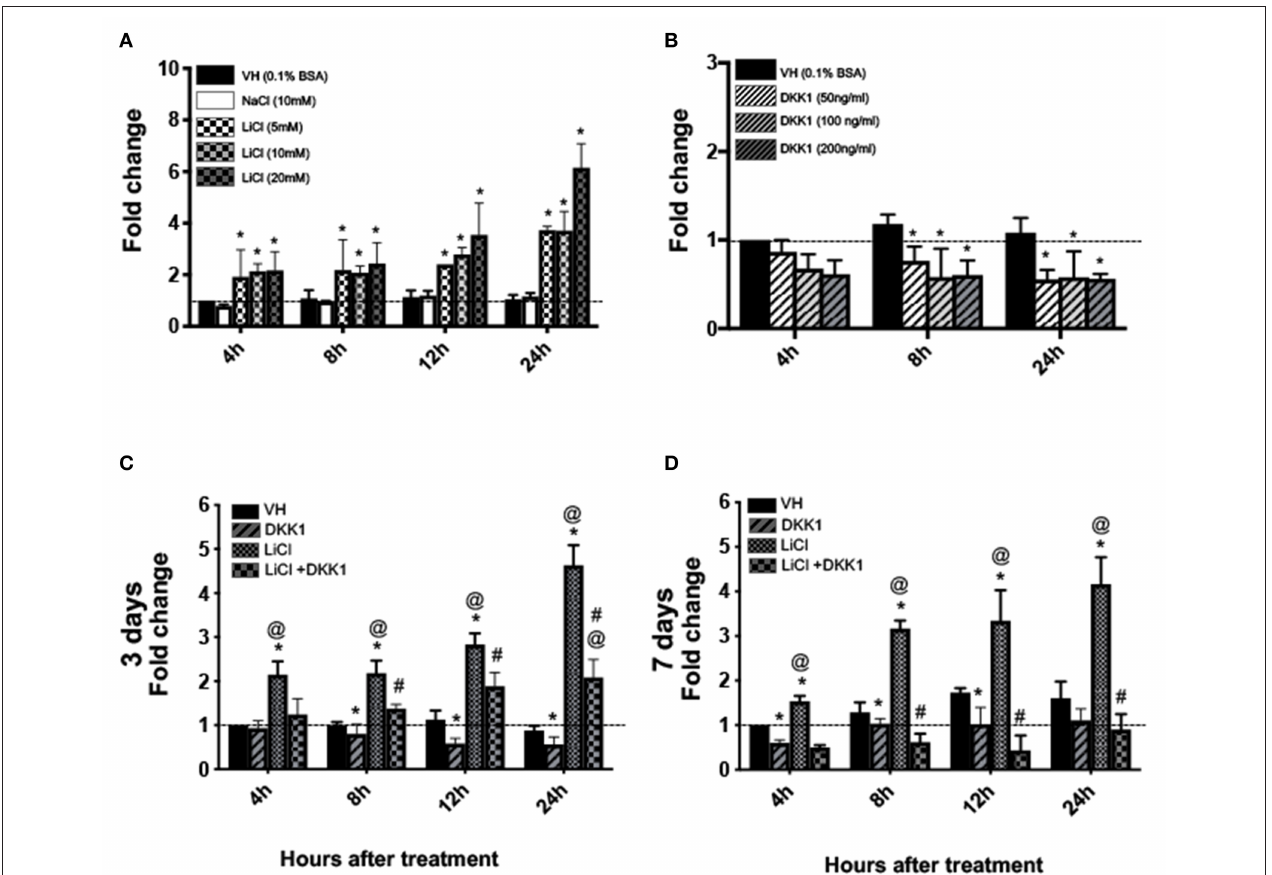
FIGURE 1 | Effects of LiCl on Axin2-expression in primary pulp cultures cultures. (A,B) Graphs showing the dose-dependent changes in the expression of Axin2 in cultures treated with Vehicle (VH, 0.1% BSA), (A) NaCl (10mM), LiCl (5, 10, and 20mM), and (B) DKK1 (50, 100, and 200ng/ml) between 4 and 24h after treatment at various times at day 3. (C,D) Graphs showing changes in the expression of Axin2 between 4 and 24h in cultures with various treatments at day 3 (C) and day 7 (D) . Expression of Axin2 was normalized to 4h of the VH-treated cultures, which is arbitrarily set to 1 and is indicated by the dashed line. Results represent mean ± SEM of at least 3 independent experiments. Analysis was performed using 1-way analysis of variance. * P ≤ 0.05 relative to VH at each time point; @ P ≤ 0.05 relative to DKK1 at each time point; # P ≤ 0.05 relative to LiCl at each time